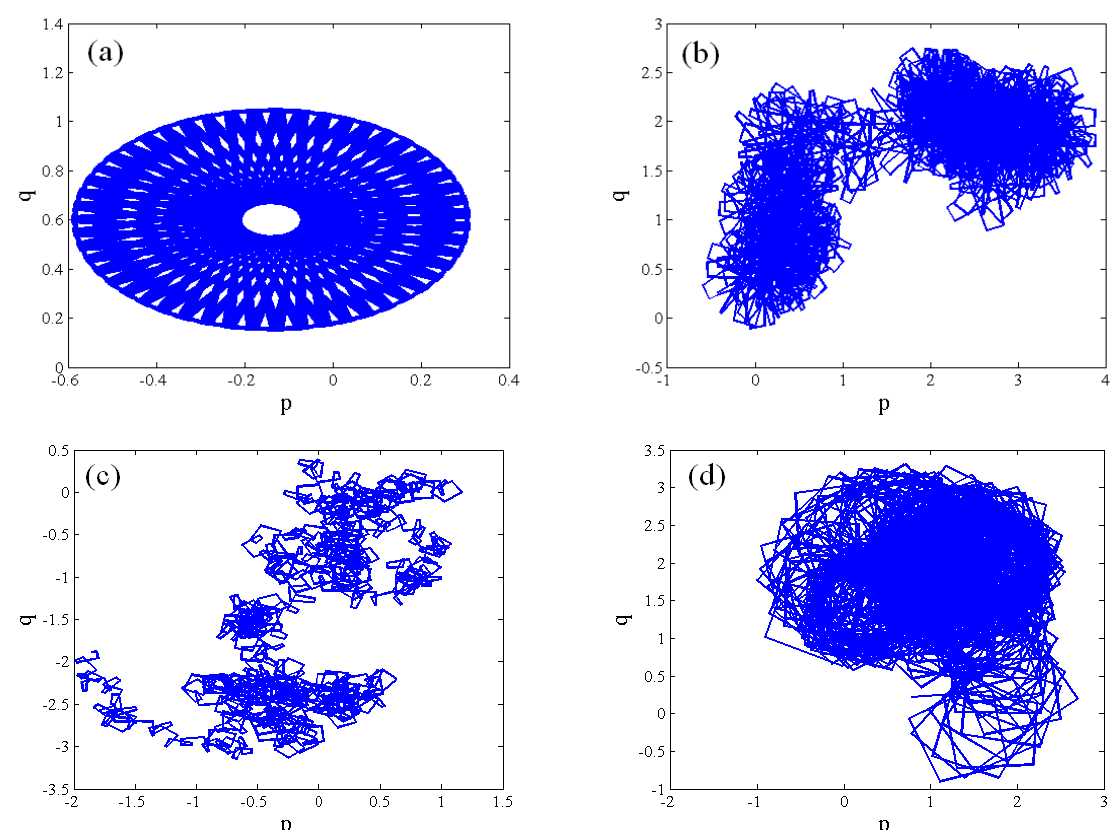
Figure 7. Asymptotic growth rate K of the fractional-order map with regard to r.